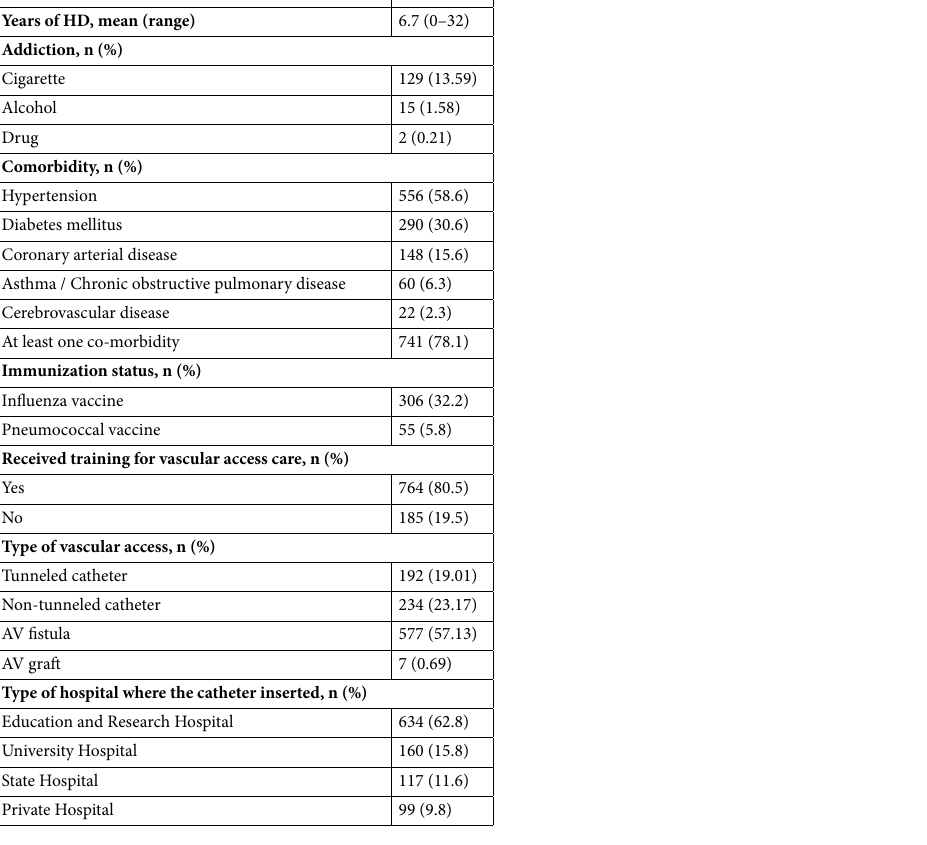
Table 1. Characteristics of the patients (n =